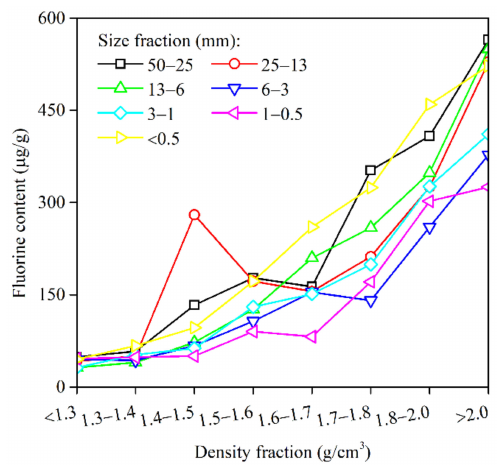
Figure 2. The fluorine content of different density fractions.